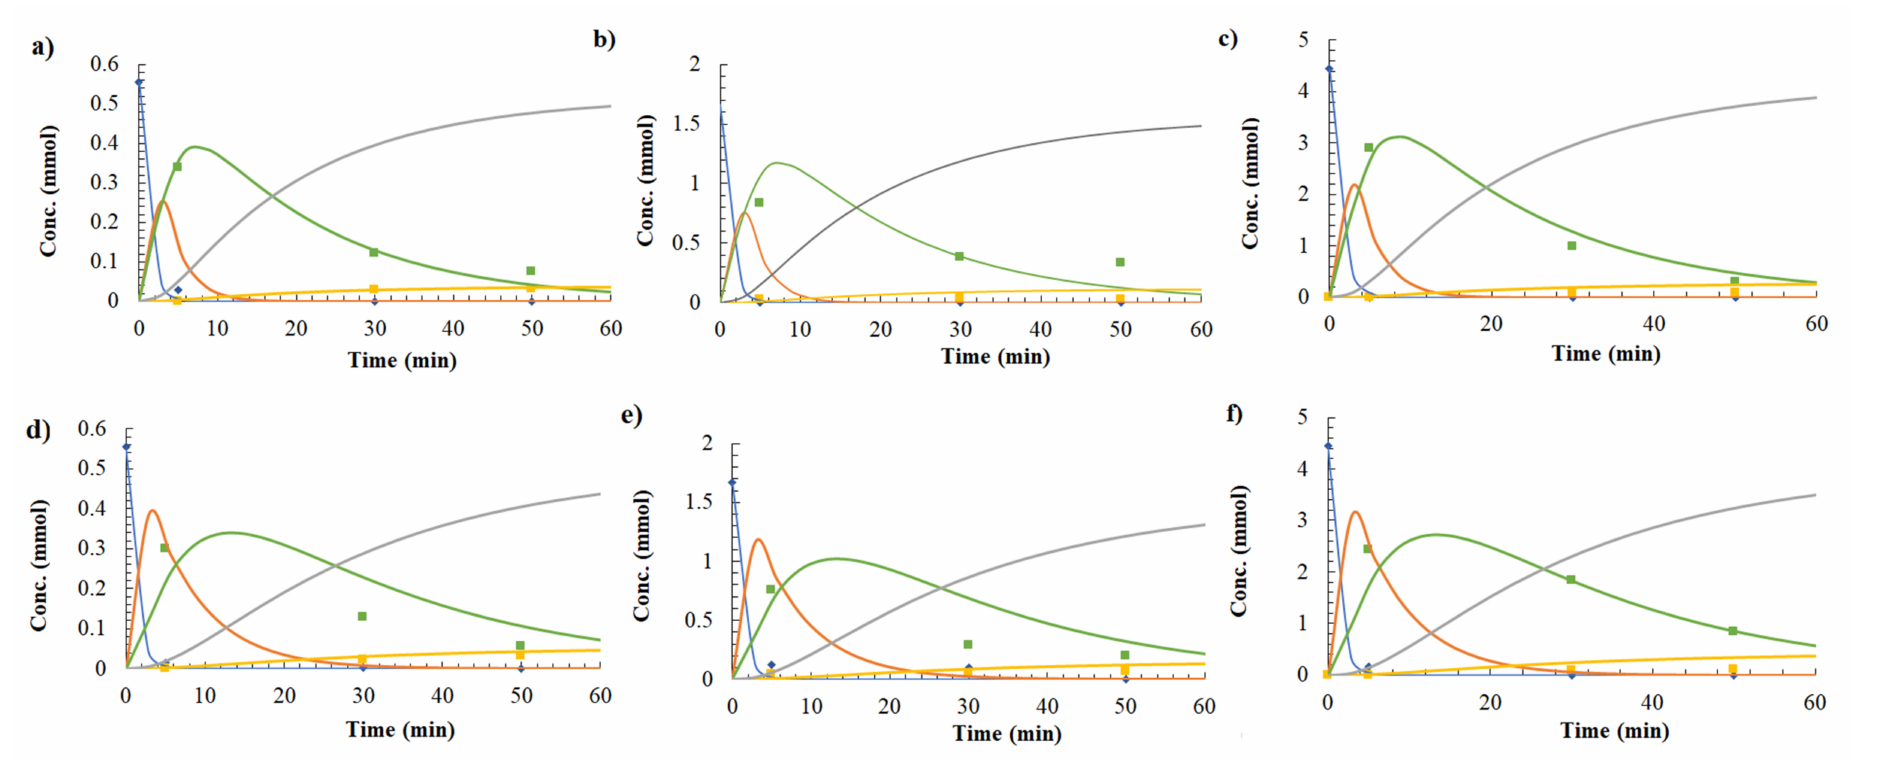
Figure 5. Performance profile of the products of acid-catalyzed fructose dehydration at ( a – c ) 160 ◦ C and ( d – f ) 170 ◦ C for 100, 300, and 800 mg using MW heating with 3 mL solvent, 10 mg MIL-101(Cr)-SO 3 H(3), and 100 mg fructose (0.56 mmol). Symbols denote experimental values: ( (cid:4) , — ) fructose conversion, ( — ) intermediate formation, ( (cid:4) , — ) 5-HMF production, ( (cid:4) , — ) LA + FA production, ( — ) side product